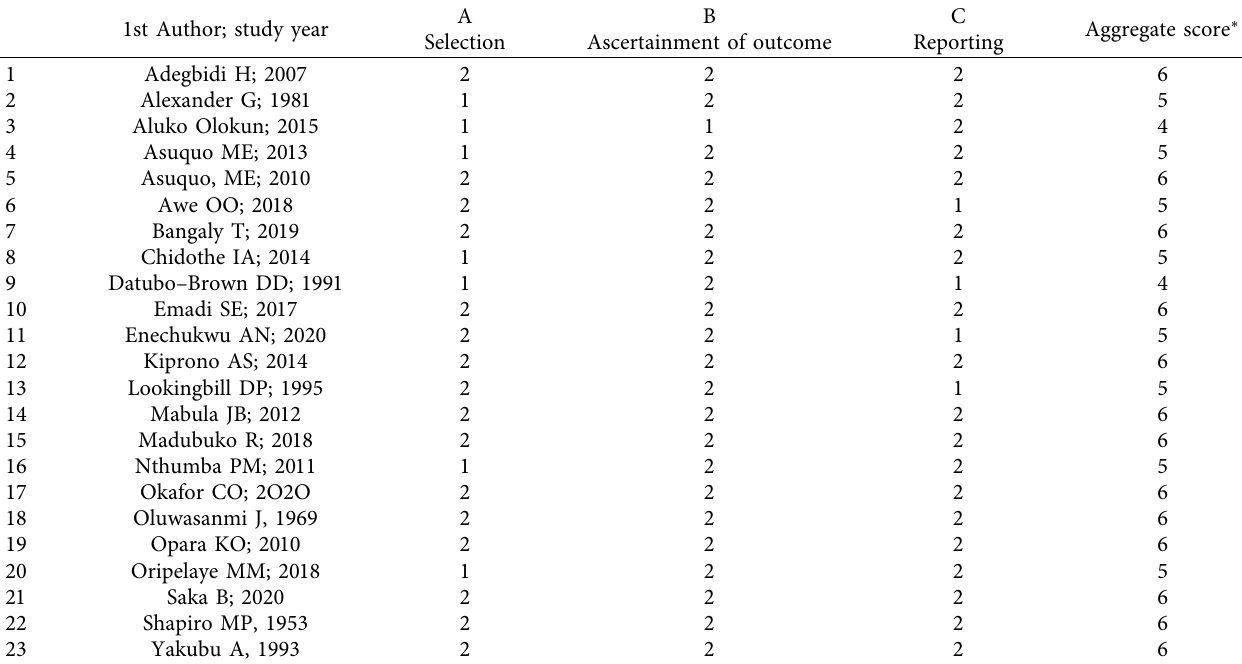
Table 3: Risk of bias assessment score for each of the included